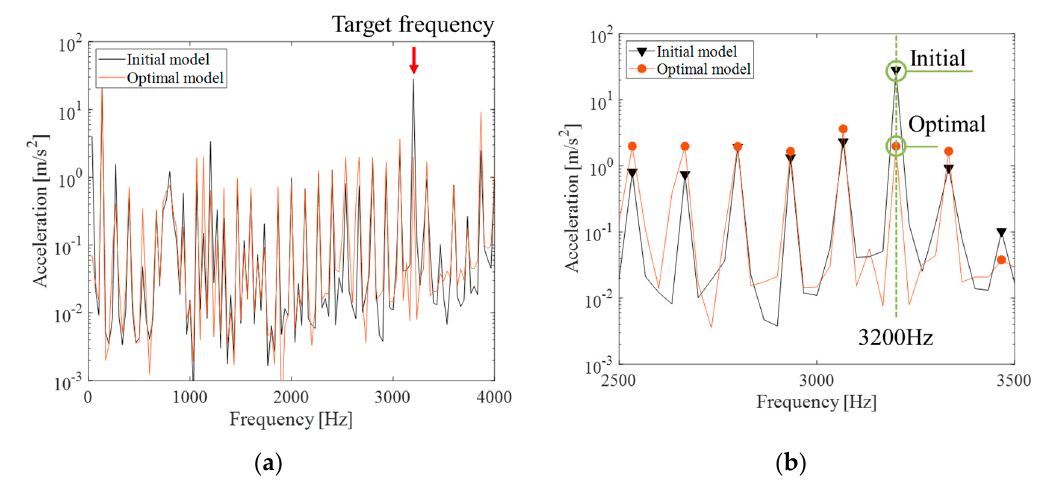
Figure 8. Comparison of acceleration response of Rectangular shape housing design ( a ) entire frequency range ( b ) narrow frequency range.